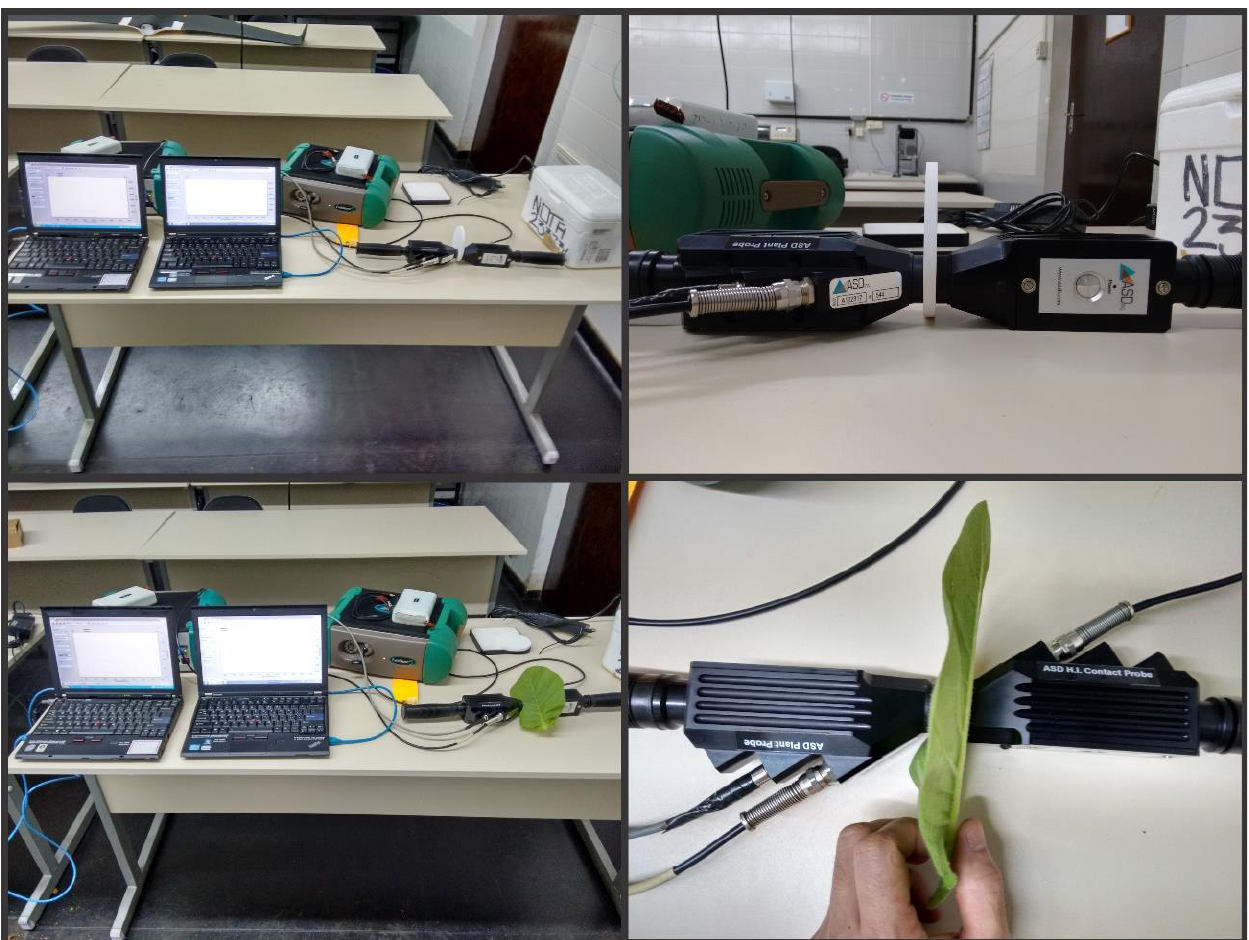
Figure 3. A representative image displays two spectroradiometers for the simultaneous collection of reflectance and transmittance data. ( Top ) the spectroradiometers were calibrated with a Spectralon ® . ( Bottom ) data were collected from Nicotiana tabacum leaves using Plant Probes.